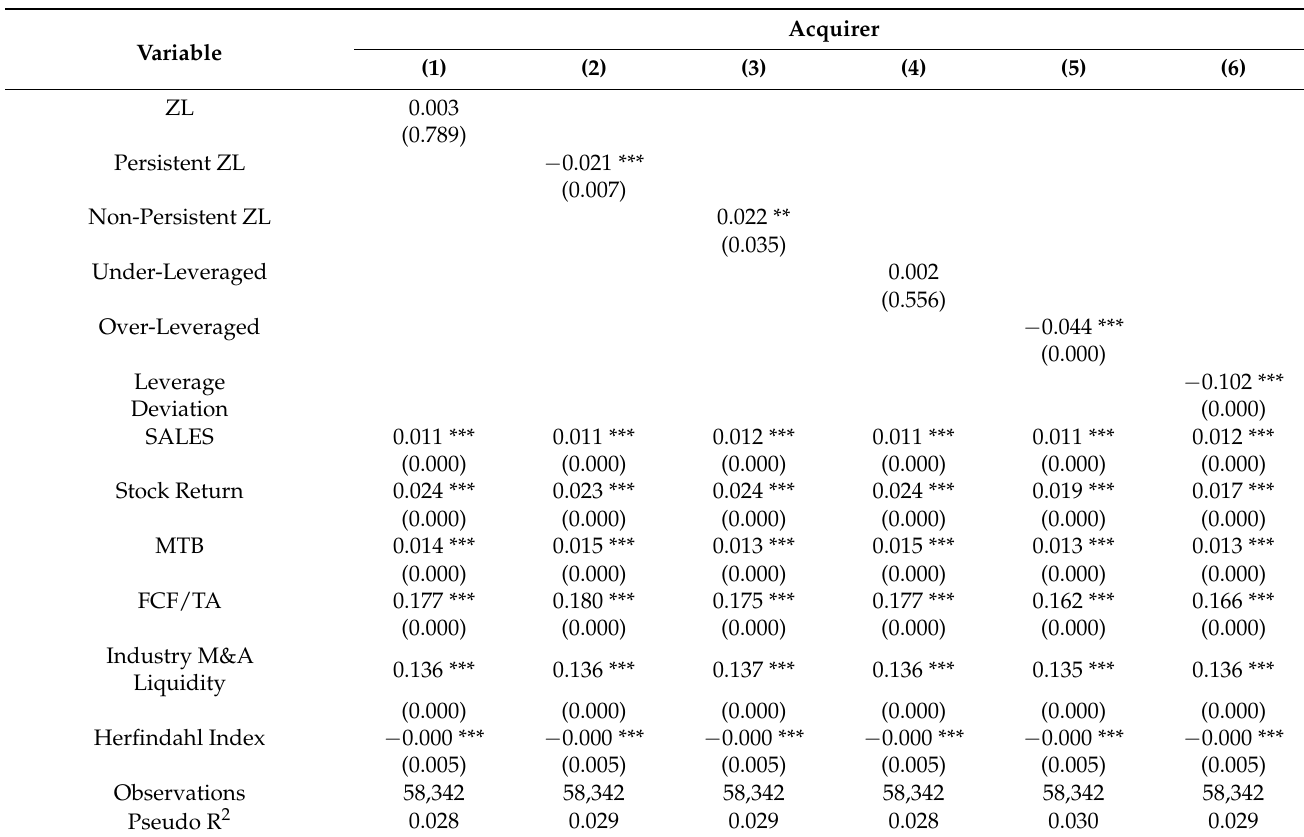
Table 4. The effect of leverage deviation on the likelihood of acquisitions. This table presents the results of probit regressions examining the effect of ZL, persistent ZL, non-persistent ZL, under- Leveraged, over-Leveraged, and leverage deviation on the likelihood of acquisitions. The dependent variable is the indicator variable for being an acquirer. All variables are defined in Appendix A. The average marginal effects of probit regressions are reported. Each regression includes year dummies. The p -values reported in parenthesis are based on standard errors clustered by 3-digit SIC industry. The symbols *** and ** denote statistical significance at the 1% and 5%.